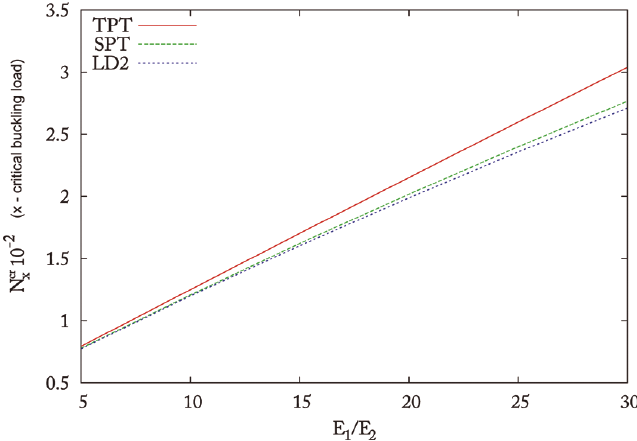
Fig. 5. PLATE-31 with E 1 /E 2 = open, Q4, 10 × 10, a/h = 30, a = b, SSSS.